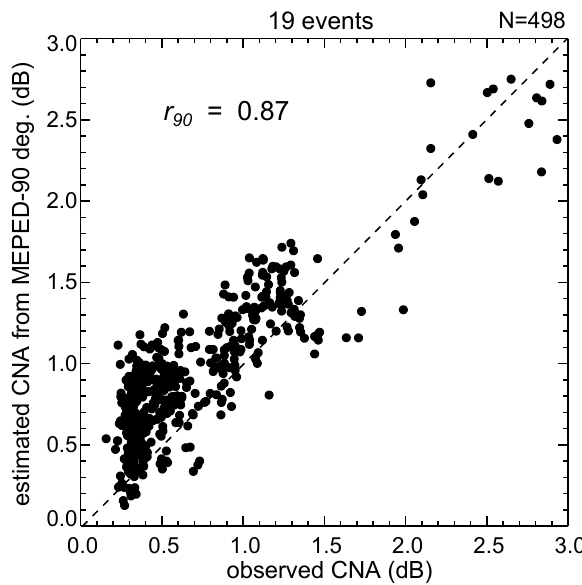
Fig. 6. Scatter plot of observed CNA versus CNA estimated using the trapped electron flux from the MEPED-90 ◦ for all the selected events. The format of this figure is the same as Fig.